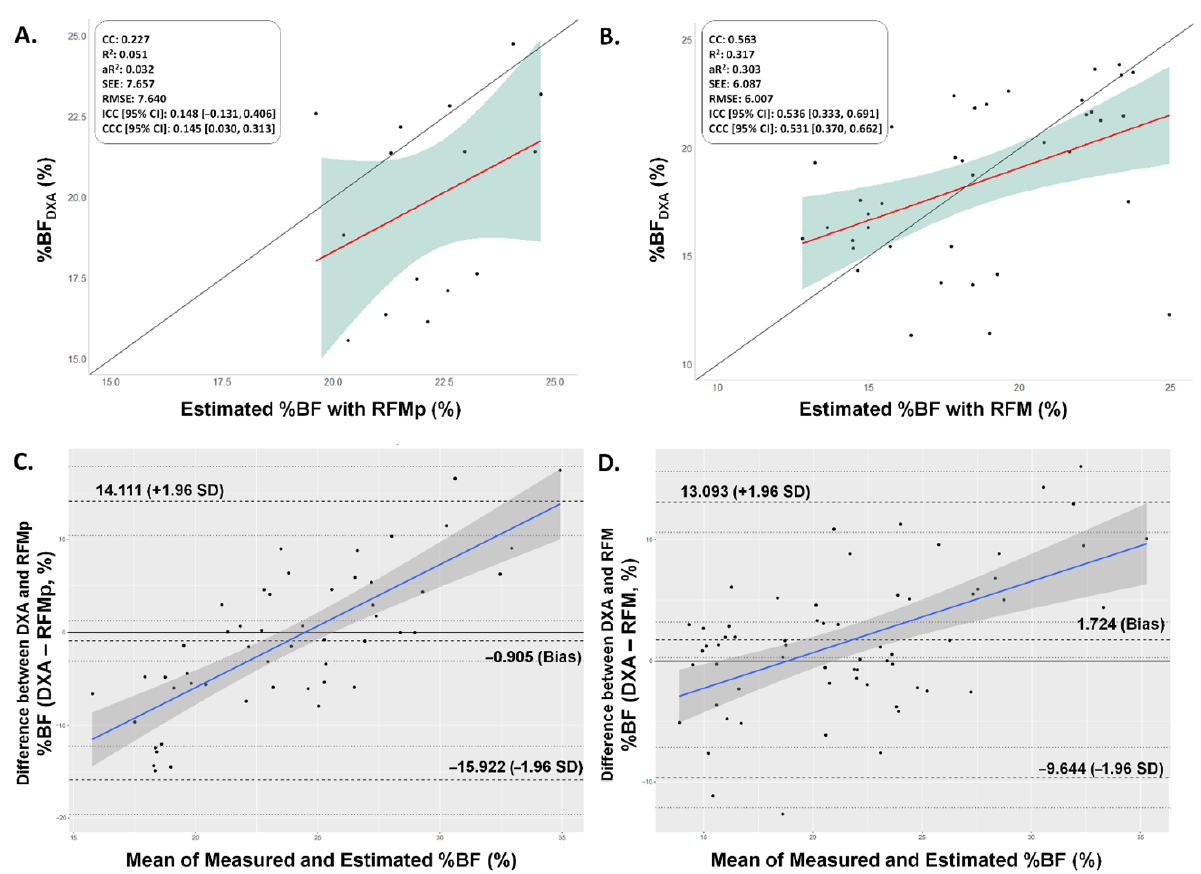
Figure 1. External validation of the RFMp and RFM in young Colombian athletes. ( A ) Concordance correlation plot of DXA measurements and estimations with RFMp. ( B ) Concordance correlation plot of DXA measurements and estimations with RFM. The solid 45° line represents perfect con- cordance while the red line represents the linear regression line through the observations. CC: Cor- relation coefficient; R 2 : Coefficient of determination; R 2 a: Adjusted coefficient of determination; SEE: Standard error of the estimation; RMSE: Root mean square error; ICC: Intraclass correlation coeffi- cient; CCC: Concordance correlation coefficient ( ρ c ). ( C ) Bland–Altman plot for differences between measured and estimated %BF with the values obtained by the RFMp. ( D ) Bland–Altman plot for differences between measured and estimated %BF with the values obtained by the RFM. Individual differences between real and estimated %BF values are plotted against the mean of the values of measured and estimated %BF. Limits of Agreement are shown as dashed black lines with 95% con- fidence intervals, bias (as dashed black line) with 95% confidence interval, and regression fit of the differences on the means (as solid blue line). 3.3. New Waist Girth-Based Equation to Estimate Fat Mass in Young Athletes After the evaluation of all models with all possible combinations of predictor varia- bles to estimate fat mass in kilograms (127 models in total), the best performance was obtained in the model that included Sex, BM/W and W/Stature as explainable variables for estimating fat mass. Table 3 shows the performance metrics of the top ten models with three regressors to estimate fat mass (see all possible models including all regressors in Supplementary File S1). All models are expressed as Ŷ = β 0 + β 1 X 1 + β 2 X 2 + β 3 X 3 . It is im- portant to note that models with maximum three regressors were prioritized for simplicity and considering the a priori sample size calculation. Even though we also evaluated all possible combinations to estimate %BF or fat-free mass as independent variables (data not shown), the selected model to estimate fat mass outperformed all other possibilities after the model specification process.